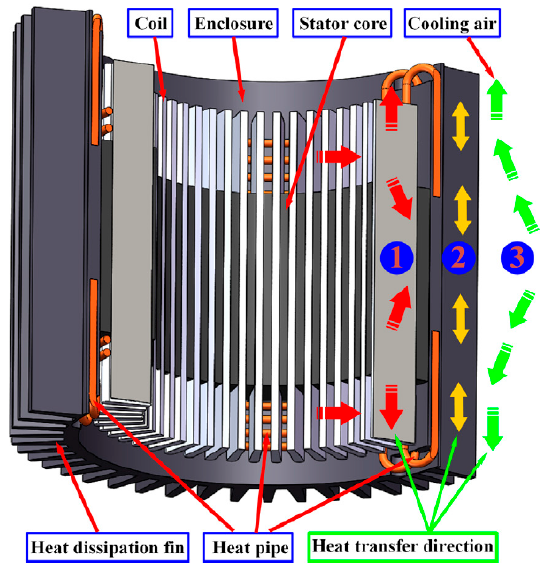
Figure 30. Heat pipe-based air-cooling with 3D rounding module (RM) [62].